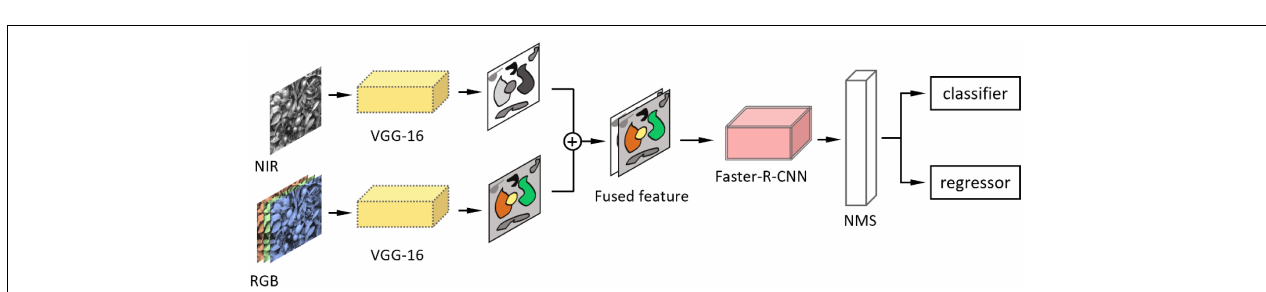
FIGURE 13 | Diagram of fusion methods in Sa et al. (2016). (A) Early fusion: first, channels of the detected image are augmented from three to four channels. Second, the augmented image is detected by Faster-R-CNN. Third, NMS (non-maximum suppression) removes duplicate predictions. Finally, the classifier and regressor calculate the category and coordinate of the bounding box. (B) Late fusion: first, the RGB image and the NIR image are detected by Faster-R-CNN. Second, the detected outputs from two Faster R-CNN networks are fused. Third, NMS (non-maximum suppression) removes duplicate predictions. Finally, the classifier and regressor calculate the category and coordinate of the bounding box.